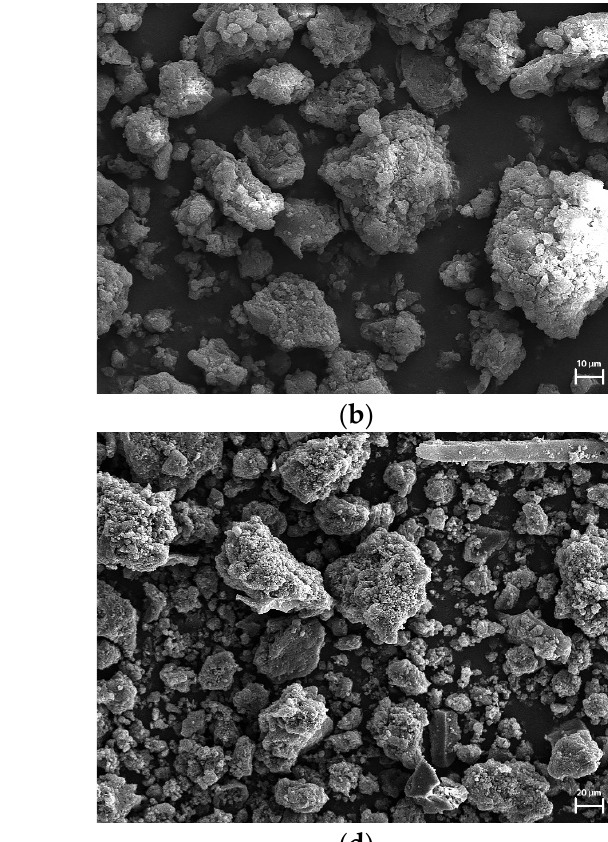
Figure 2. Low-temperature nitrogen adsorption/desorption isotherms of samples obtained. The SEM micrographs of the obtained biocarbons are presented in Figure 3. The brighter fragments observed on the biocarbons may be due to the presence of ash content.